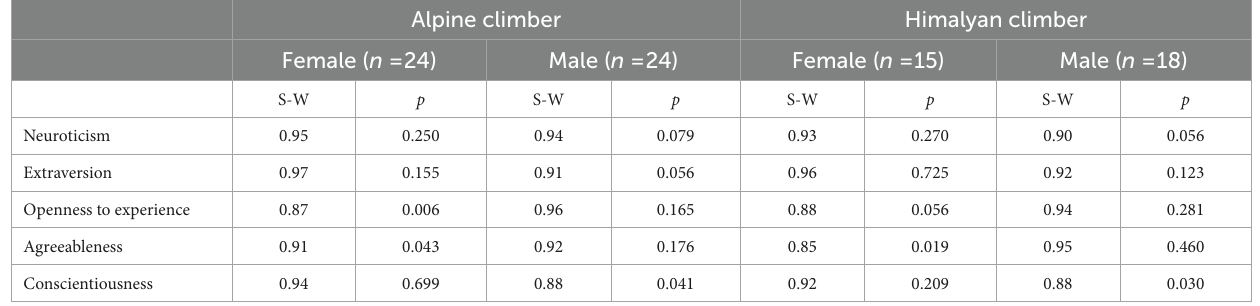
TABLE 2 Results of the normality of distribution test for individual personality traits by group. Alpine climber Himalyan climber Female ( n = 24) Male ( n = 24) Female ( n =